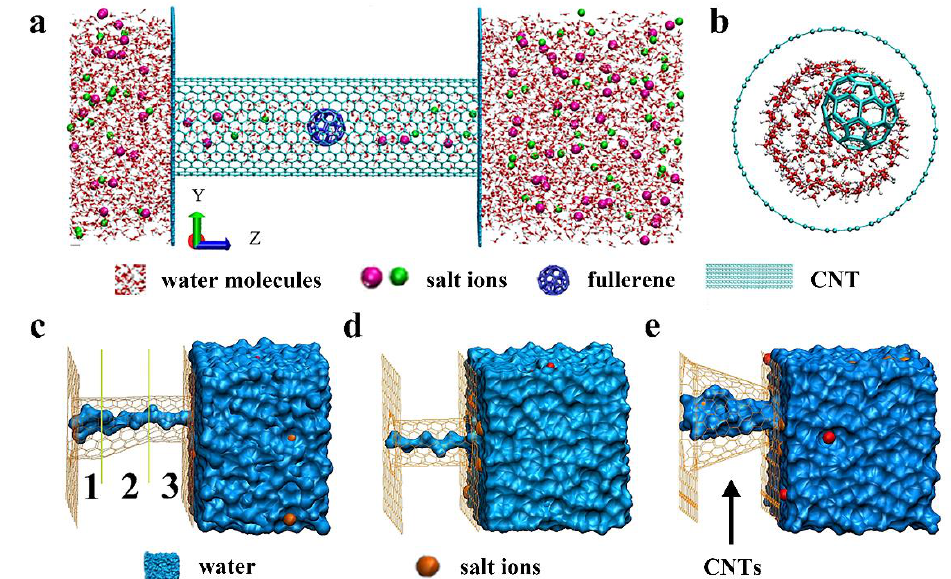
Figure 3. Characteristics affecting the water flow rate of CNTs. The initial structure of the F@CNT ( a ) from the side view and ( b ) the front view snapshot (Reproduced or adapted from ref. [38], with permission from Elsevier, 2019). Schematics of different shapes of CNTs; ( c ) hetero-junction CNT, ( d )